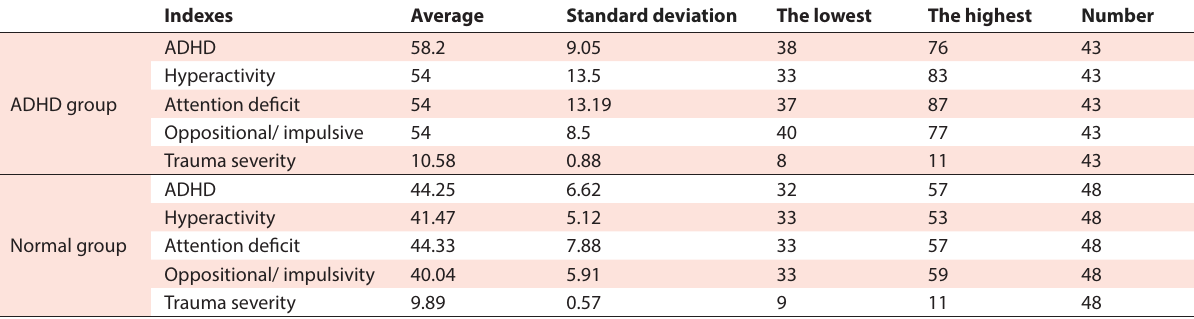
Table 2. Descriptive index of variables studied in differentiated groups